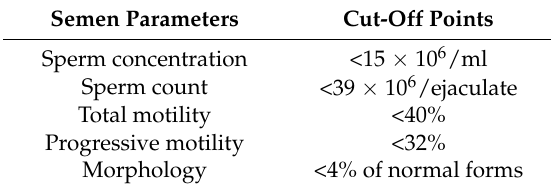
Table 1. Cut-off points used to evaluate abnormal values of semen quality parameters [17].